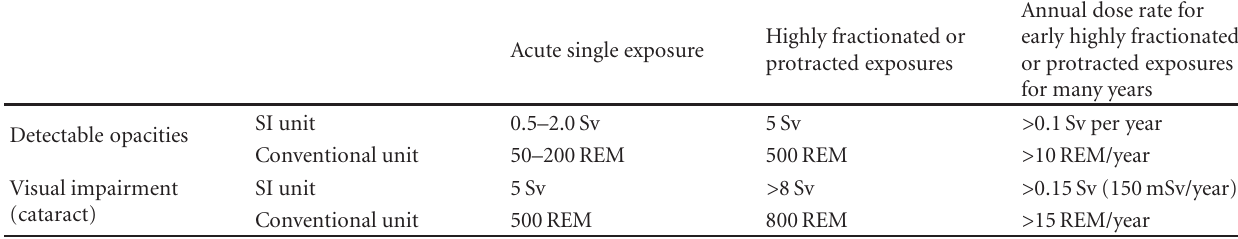
Table 1: ICRP threshold dose values for damage to the eyes in Sv and REM [5, 13].